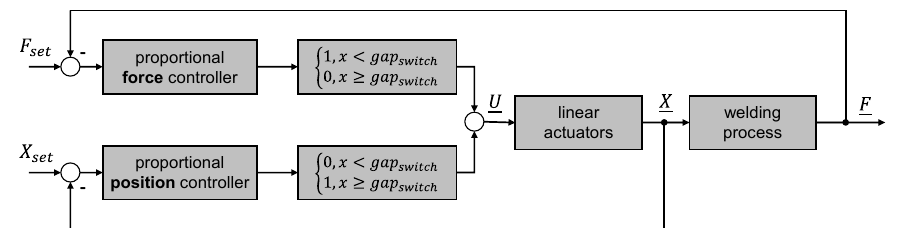
Figure 14. Closed-loop force-position control.